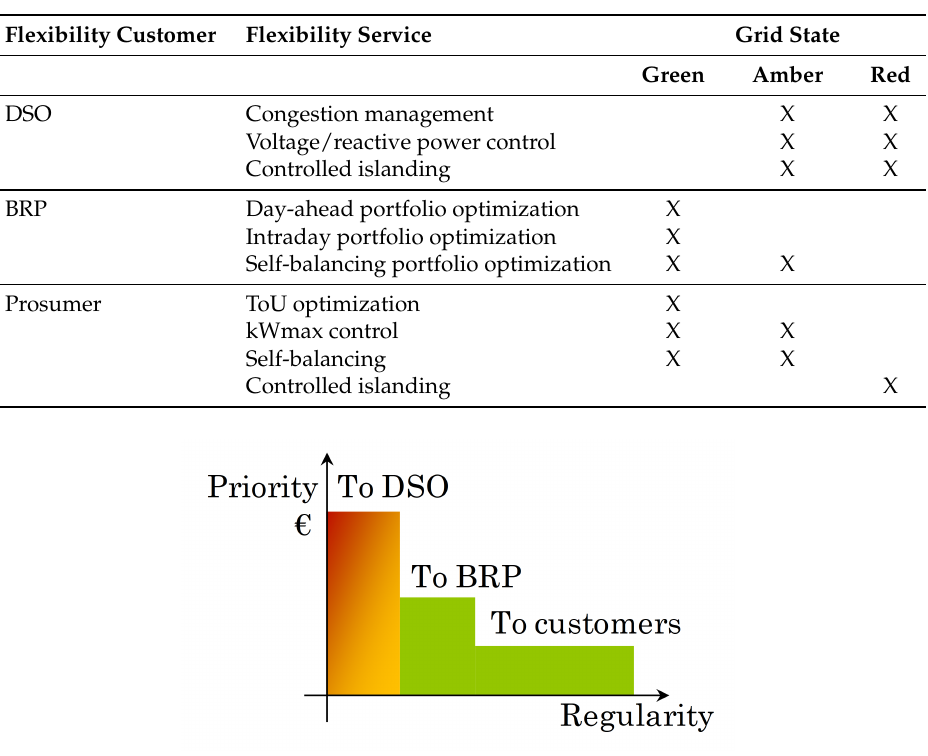
Figure 2. Traffic light concept applied to the flexibility services and